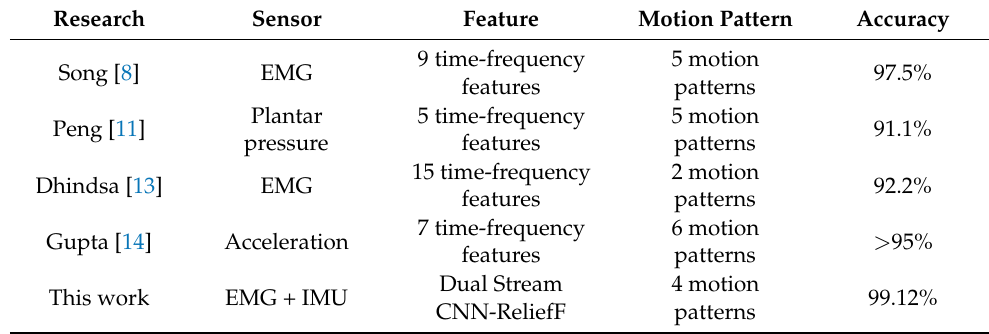
Table 5. Comparison of the methods and experimental